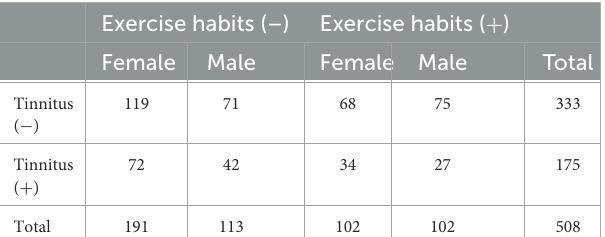
TABLE 5 Relationship between tinnitus and exercise